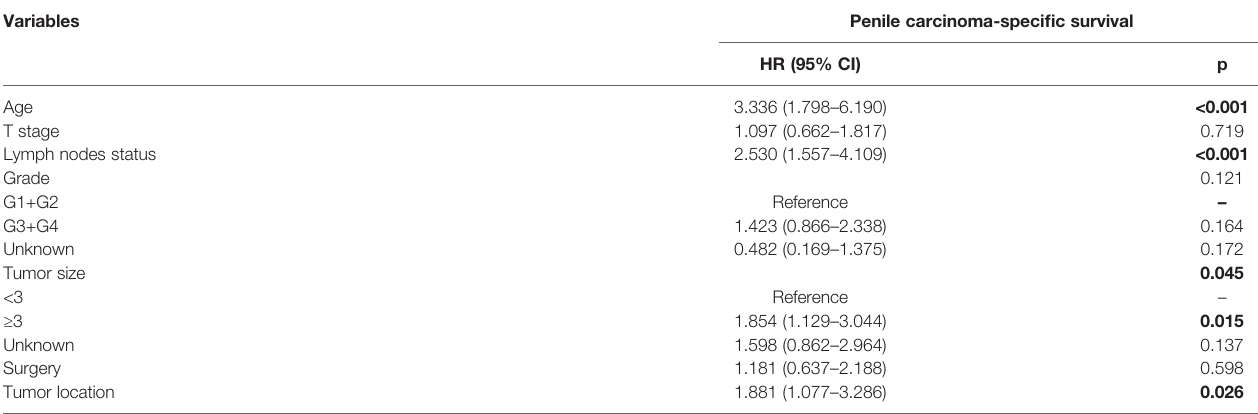
TABLE 3 | Multivariate Cox regression analyses predicting penile carcinoma-speci fi c survival.